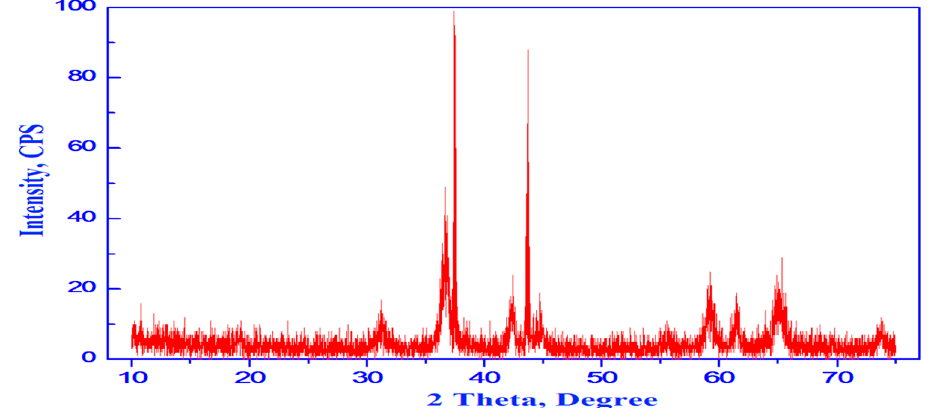
Figure 3. XRD pattern of CoO/Co 3 O 4 nanoparticles.